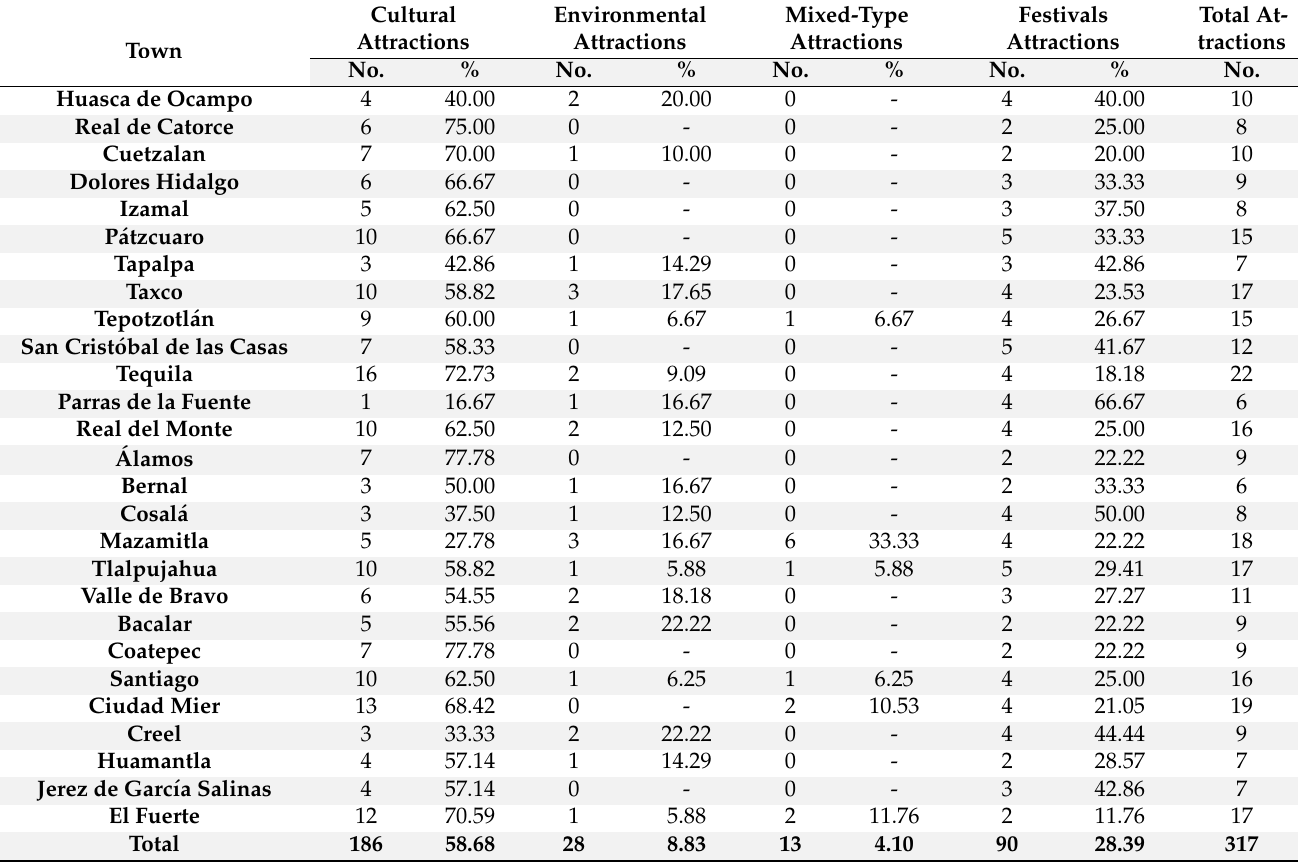
Table 2. Description of tourist values in studied